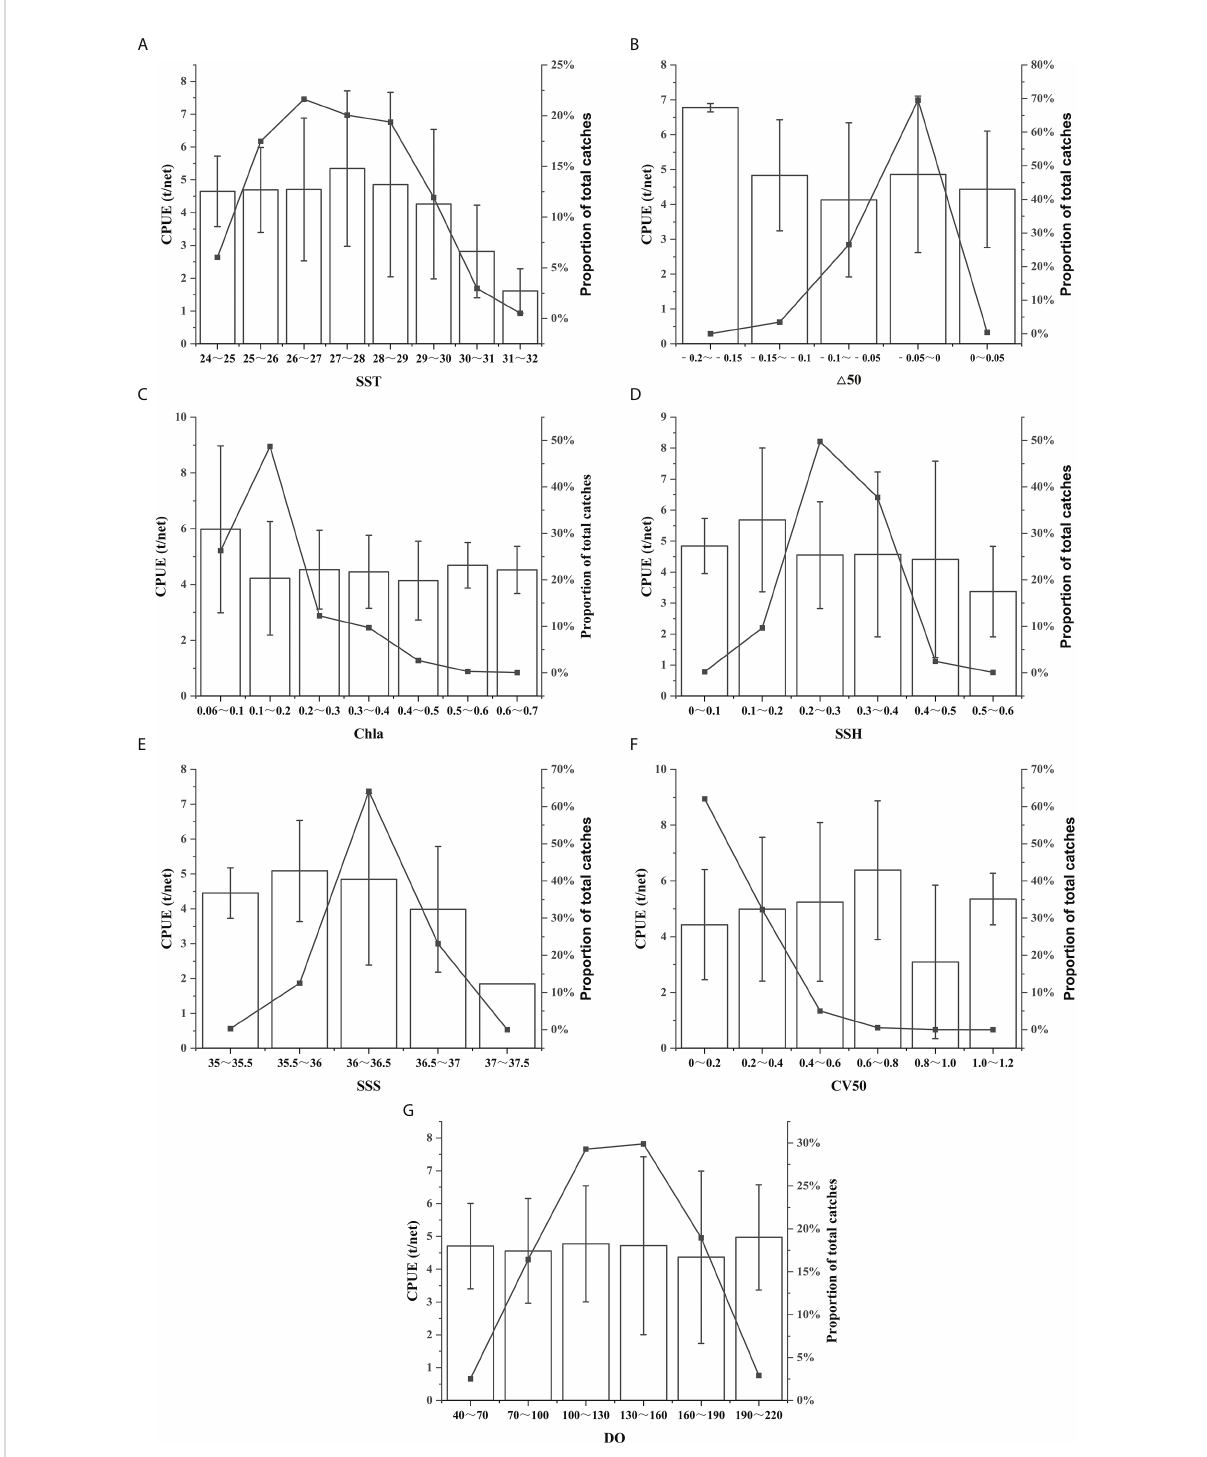
FIGURE 7 Relationship between CPUE, catches, and environment variables ( (A) SST, (B) △ 50, (C) Chla, (D) SSH, (E) SSS, (F) CV50, (G) DO. mean ± standard